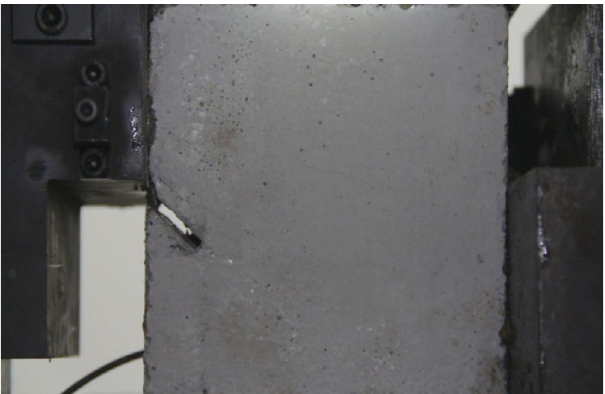
Figure 16. Photograph of a specimen showing fractures appearing from the left boundary of the rock mass.